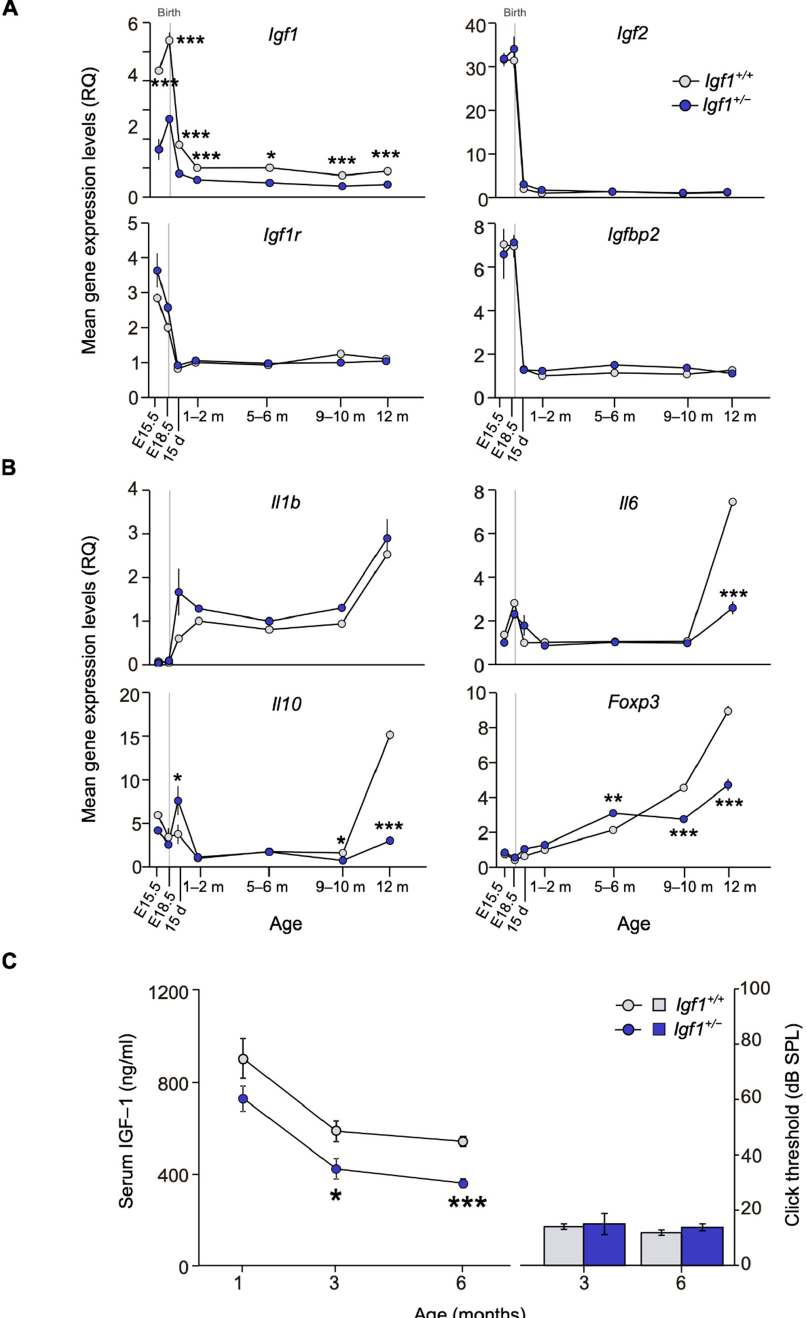
Figure 1. Evolution of cochlear gene expression and IGF-1 plasma levels in Igf1-heterozygous mice with age. ( A , B ) Cochlear gene expression of Igf1, Igf2, Igf1r, and Igfbp2 ( A ) and of Il1b, Il6, Il10, and Foxp3 ( B ) in WT and Igf1 +/ − mice from embryonic (E) to adult stages. Expression levels were measured by RT-qPCR and calculated as 2 − ∆∆ Ct (RQ), using Hprt1 as reference gene and normalized with the 1–2-month-old WT mice group. Values are presented as mean ± SEM of triplicates from pool samples of 3 mice per condition from two independent experiments. Statistically significant differences were analyzed by Student’s t -test (* p < 0.05, ** p < 0.01, *** p < 0.001 between genotypes). ( C ) IGF-1 serum levels (mean ± SEM of at least 4 mice per condition) were analyzed by ELISA in WT and Igf1 +/ − mice in one-, three- and six-month-old mice. ABR thresholds (mean ± SEM) for three and six-month-old WT and Igf1 +/ − mice did not vary and are shown for reference. Statistically significant differences were analyzed by Student’s t -test (* p < 0.05, *** p < 0.001). Days (d) and months